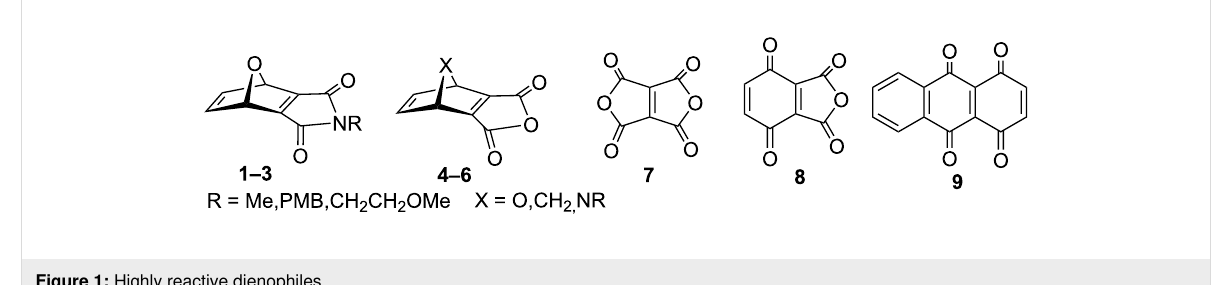
Figure 1: Highly reactive dienophiles.